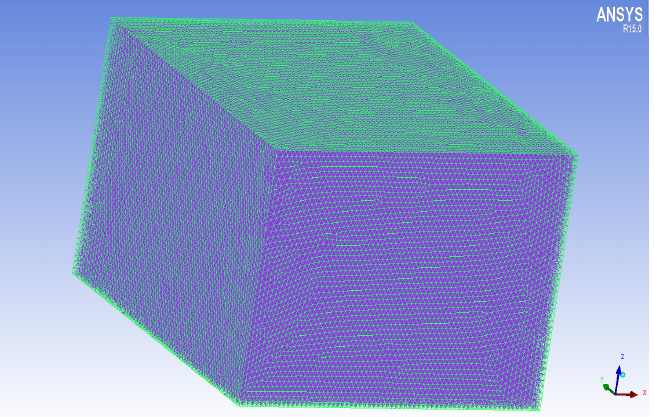
Figure 7. Grid division of external regions.